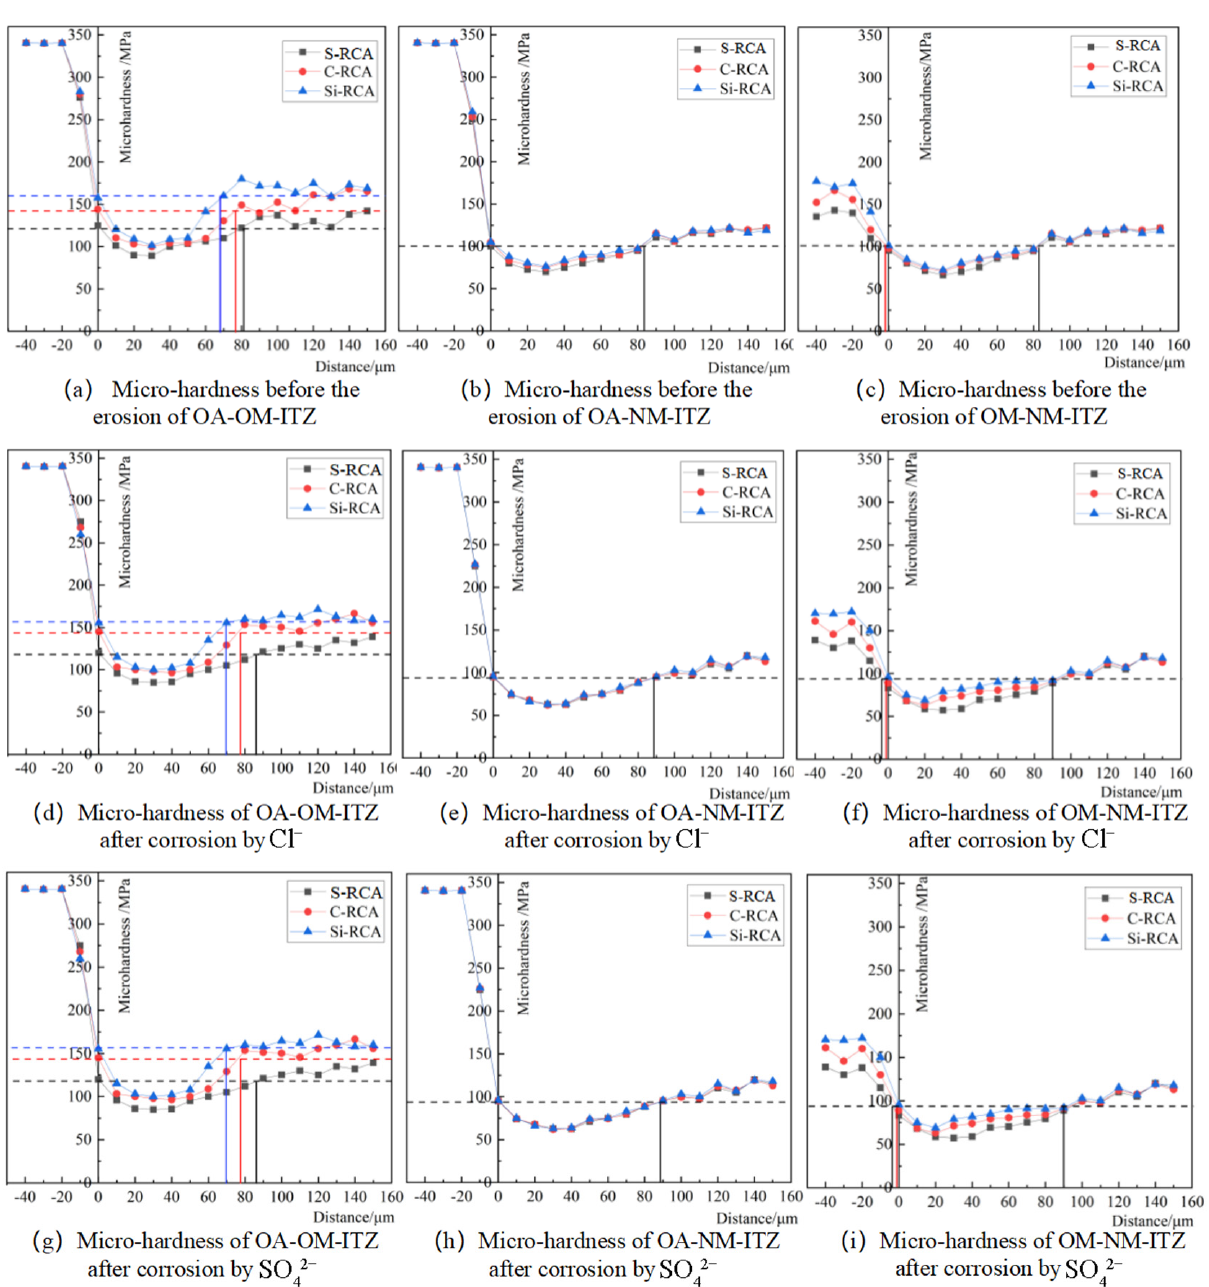
Figure 10. The micro-hardness of the ITZs before and after ions erosion.